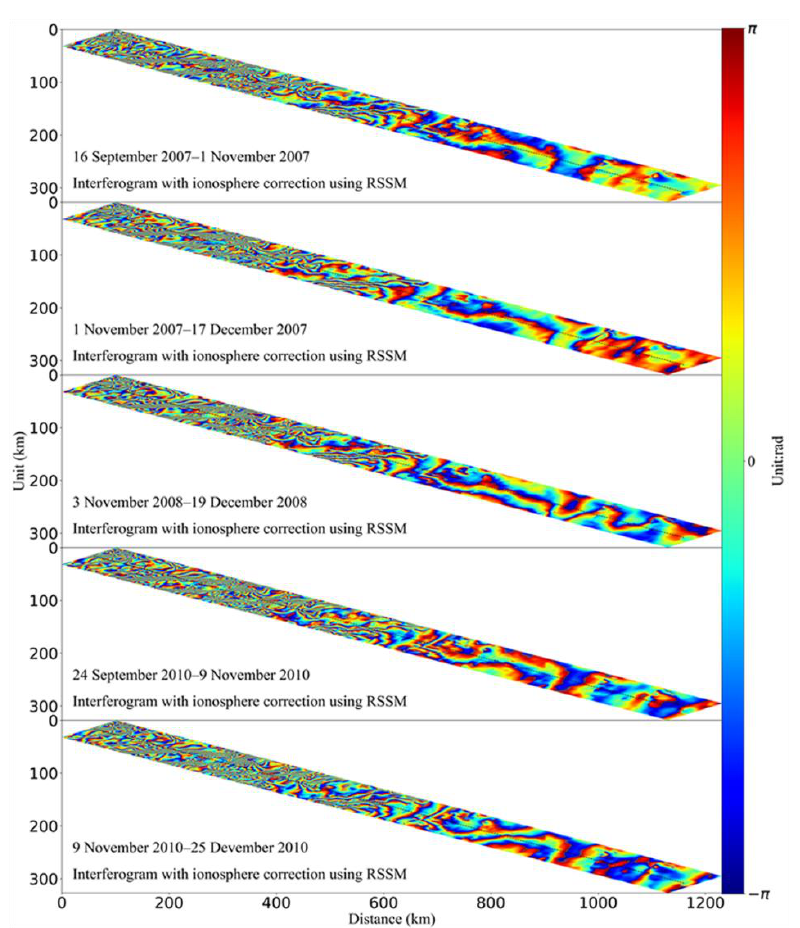
Figure 8. The time-series interferograms with ionospheric correction using the RSSM in Antarctica. The five interferograms for the five acquisition times are shown in Table 1.